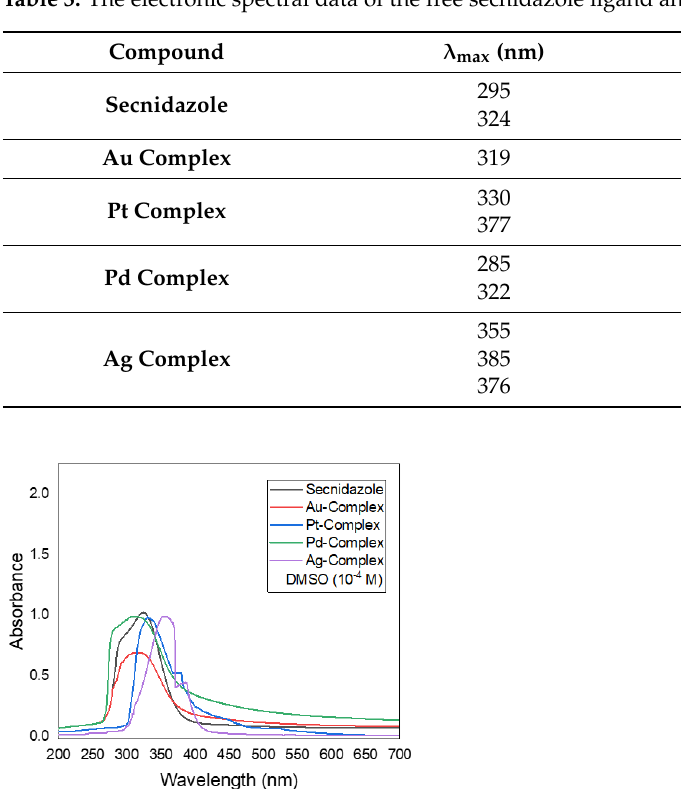
Figure 2. The UV spectra of the secnidazole ligand and its complexes. Table 3. The electronic spectral data of the free secnidazole ligand and its complexes.